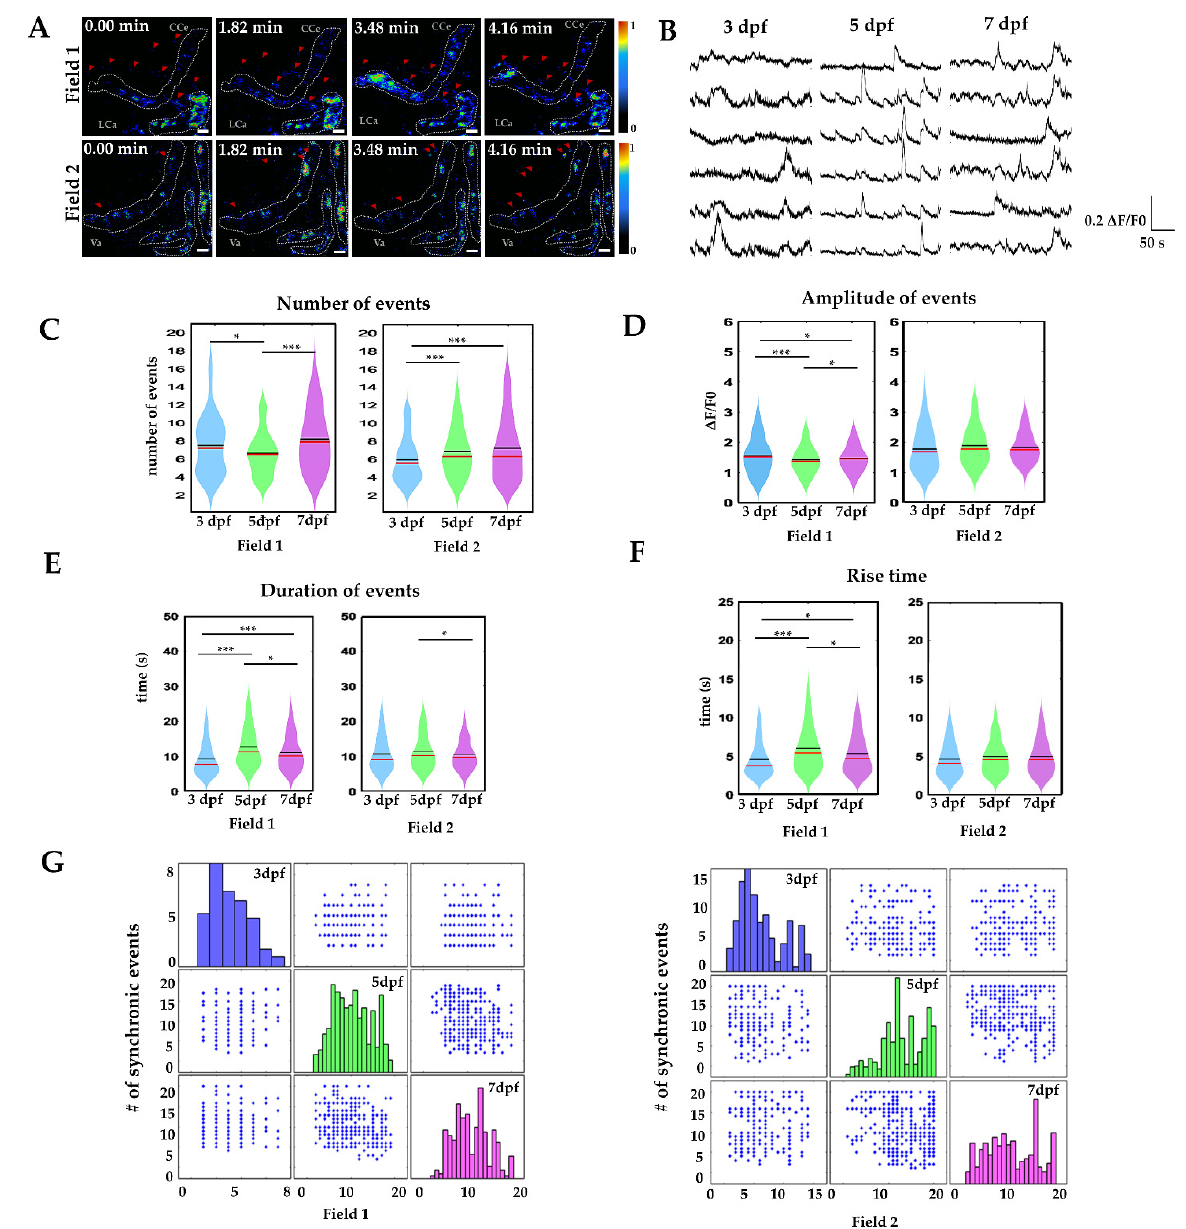
Figure 3. Calcium signalling during cerebellar development. ( A ) Calcium imaging in the lateral cerebellum at 5 dpf. A white dashed line delimits the radial glia somas; red arrowheads indicate activity in radial glia processes. ( B ) Sample recordings of calcium activity ( ∆ F/F0 during 4.16 min, at 3, 5 and 7 dpf in field 1). ( C ) Number of calcium events in 4.16 min. ( D ) Amplitude of calcium events ( Δ F/F0). ( E ) Duration of calcium events (in seconds). ( F ) Rise time of calcium events (in seconds). The boxplots show data distribution, mean values (black line) and media (red line). Nonparametric statistics, Kruskal–Wallis test, α 0.05, p -value < 0.05*, p -value < 0.001 **, p -value < 0.0001 ***. ( G ) Number of synchronic calcium events at 3 dpf, 5 dpf, 7 dpf (blue, green and magenta bars, respectively, scatter plot of x columns against y axes). For these experiments, at least 6 larvae per age and per field were recorded. Calcium events recorded per field 3 dpf n = 200, 5 dpf, n = 750, 7 dpf n = 400; scale bar 20 µm.